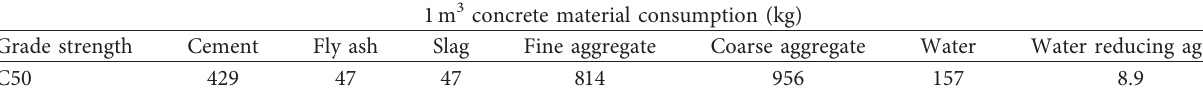
Table 1: The concrete mix proportions.